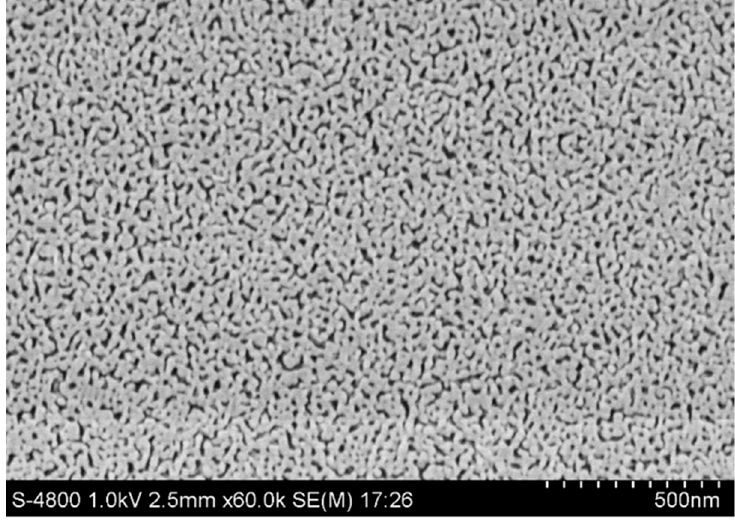
Figure 2. Scanning electron microscope (SEM) image of the as-prepared NPG film.